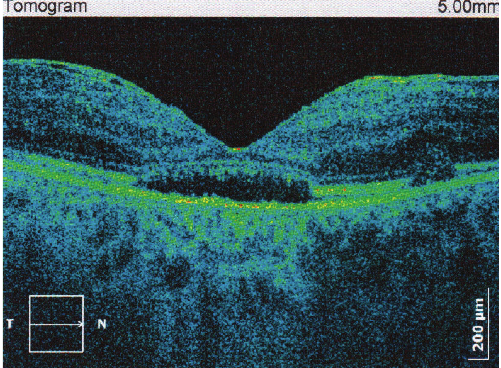
Figure 3: Retinal vasculitis, disc atrophy, and macular edema in patient with MS (right eye).